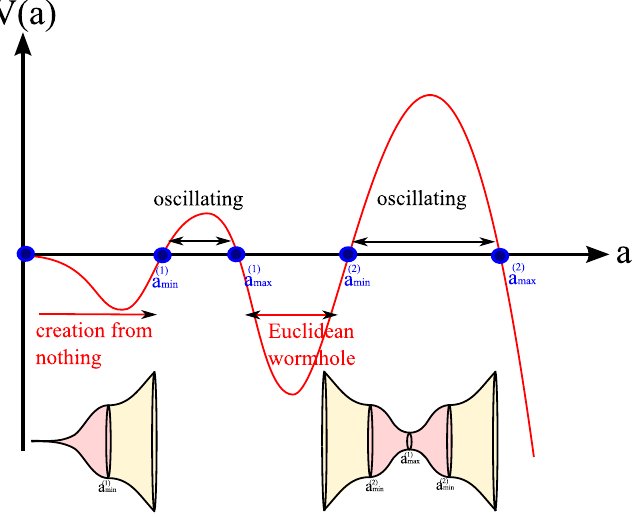
Figure 8. A conceptual interpretation of V ( a )